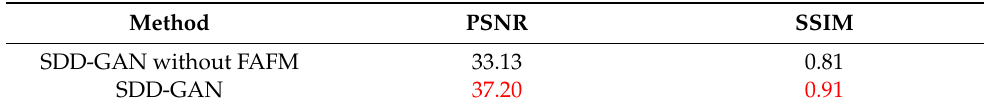
Table 5. Mean PSNR and SSIM (with FAFM vs. without FAFM) on the RSDATA dataset. The highest scores are highlighted in red.